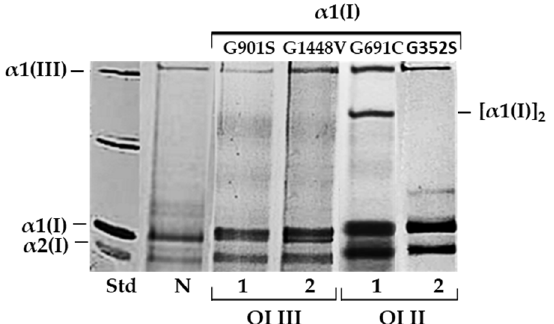
Figure 1. SDS-urea polyacrylamide gel electrophoresis (SDS-urea PAGE), in non-reducing conditions, of collagen type I in fibroblasts of patients 1 and 2 OI types III and II with glycine substitutions in α1(I) chain. To detect collagen after electrophoretic separation, silver staining was used; N—normal cells, Std—standard (bovine collagen type I) (Biocolor Life Science,